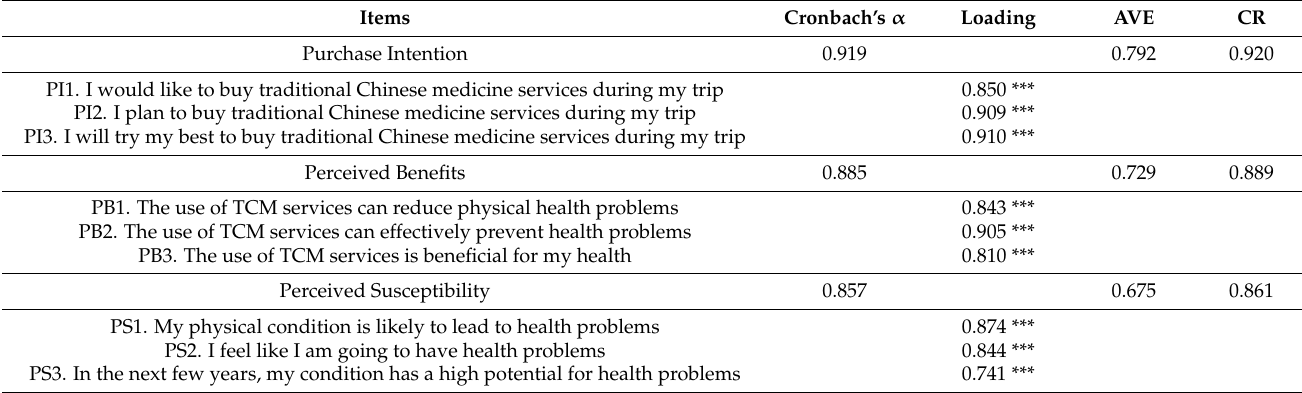
Table 1. Reliability and validity test of variable measurements (N = 269).